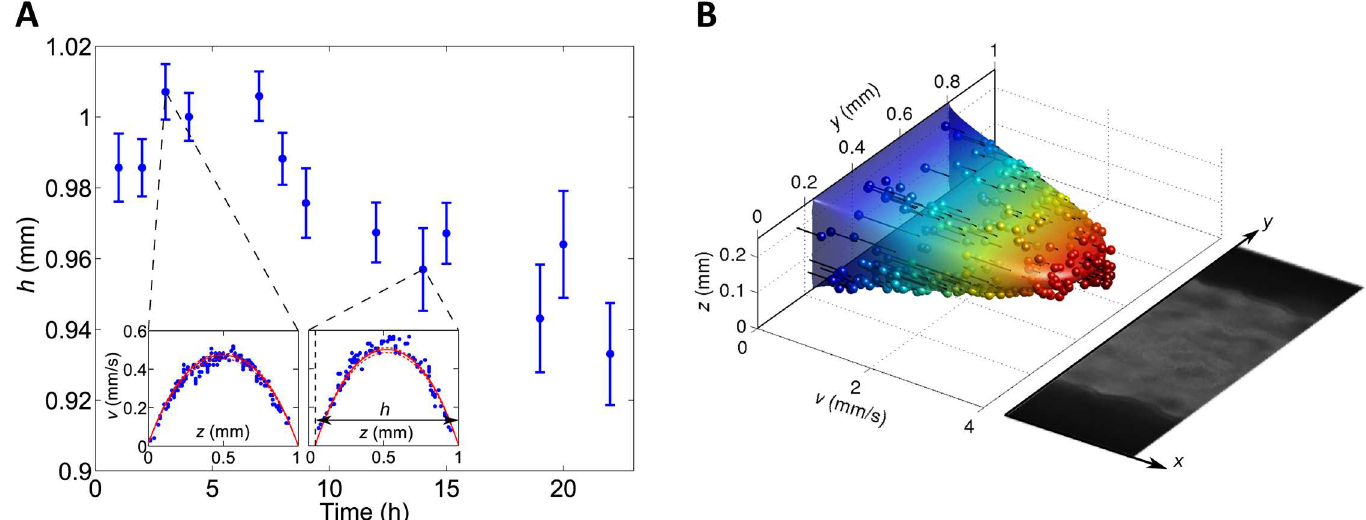
Fig 6. The velocity field evolves as the biofilm grows in the channel. (A) Effective height of a 1 mm-total-height channelin the presence of growing biofilm. Main panel: Adjustedeffective height h versus time t of biofilm growth. Error bars represent 95% confidenceintervals on h , obtained from the adjustment. Insets: examplesof adjustmentof the velocity field. Dots: experimentally-measured velocities v at various positions (y , z) across the channel. Data was collectedfor all z within a narrow band of y (width Δ y = 75 μ m << w ) locatedat the middle of the channel. Solid red curve: adjustmentto the theoretical expressionof the velocity field of a viscous fluid in a rectangularchannel(Eq 1), plotted with y in the middle of the Δ y -wideband. Dashedred curves: idem for y at each edge of the Δ y -wideband. In additionto the effective height h , the volumetric flow rate Q was adjusted(through— η dp/dx ), as in the absenceof biofilm (S3 Fig), yielding Q = 0.85 mL/h, consistent with the adjusted value Q = 0.83 mL/h obtainedin the biofilm-free case (S3 Fig). (B) Apparent size reductionin a 250 μ m-height channelcolonizedby a biofilm after 15h growth. Dots: experimentally-measured velocities v at various positions (y , z) across the channel. Surface: adjustmentto the theoretical expression of the velocity field of a viscous fluid in a rectangularchannel(Eq 1). The color scale denotesvelocities(see v axis). Black lines: distancebetweenthe experimentally-measured velocitiesand the adjusted values at the same location.Both the width w and the effective position y 0 of the no-slip boundary conditionin the y directionwere adjusted,yielding w = 0.57 mm and y 0 = 0.23 mm. The volumetric flow rate Q was set to its experimentally-imposed nominalvalue 1 mL/h, which yields a good adjustmentin the biofilm-free case (S3 Fig). The coefficient of determination of the fit is R 2 = 0.92. Picture: Growing biofilm snapshotshowingthe fluid (gray)/biofilm (black) interface matchingthe boundariesgiven by the fit.